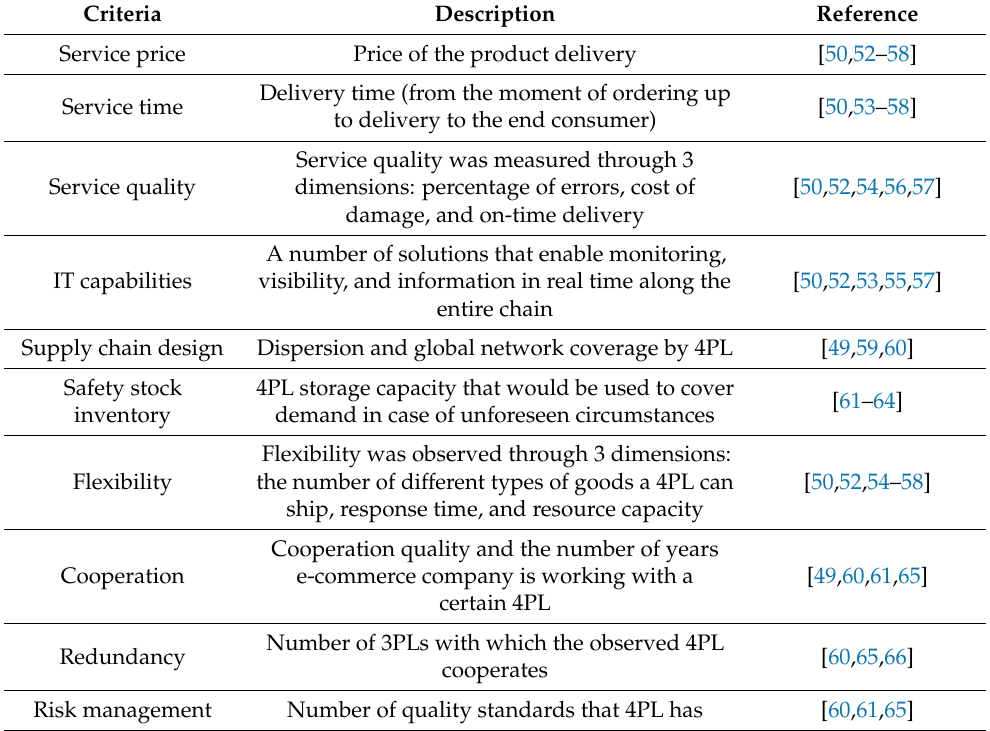
Table 3. Criteria